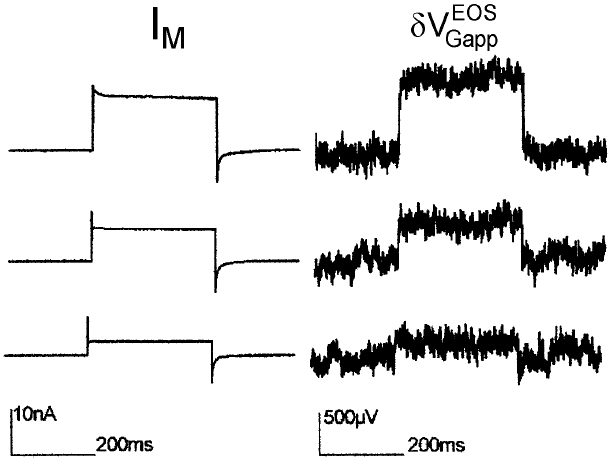
Figure 7. Transistor recording of Maxi-K potassium channel in HEK293 cell at a constant intracellular voltage with a high extracellular K concentration of 100 mM [34]. ( Left ) Total membrane current; ( Right ) Transistor recording. Depolarizations from − 100 mV to 20, 45, and 58 mV . A simulation (extracellular electrolyte 100 mM ·KCl, 35 mM ·NaCl, intracellular electrolyte 140 mM K ions) with an ion sensitivity of 12 mV for the gate oxide yields a biphasic waveform of the